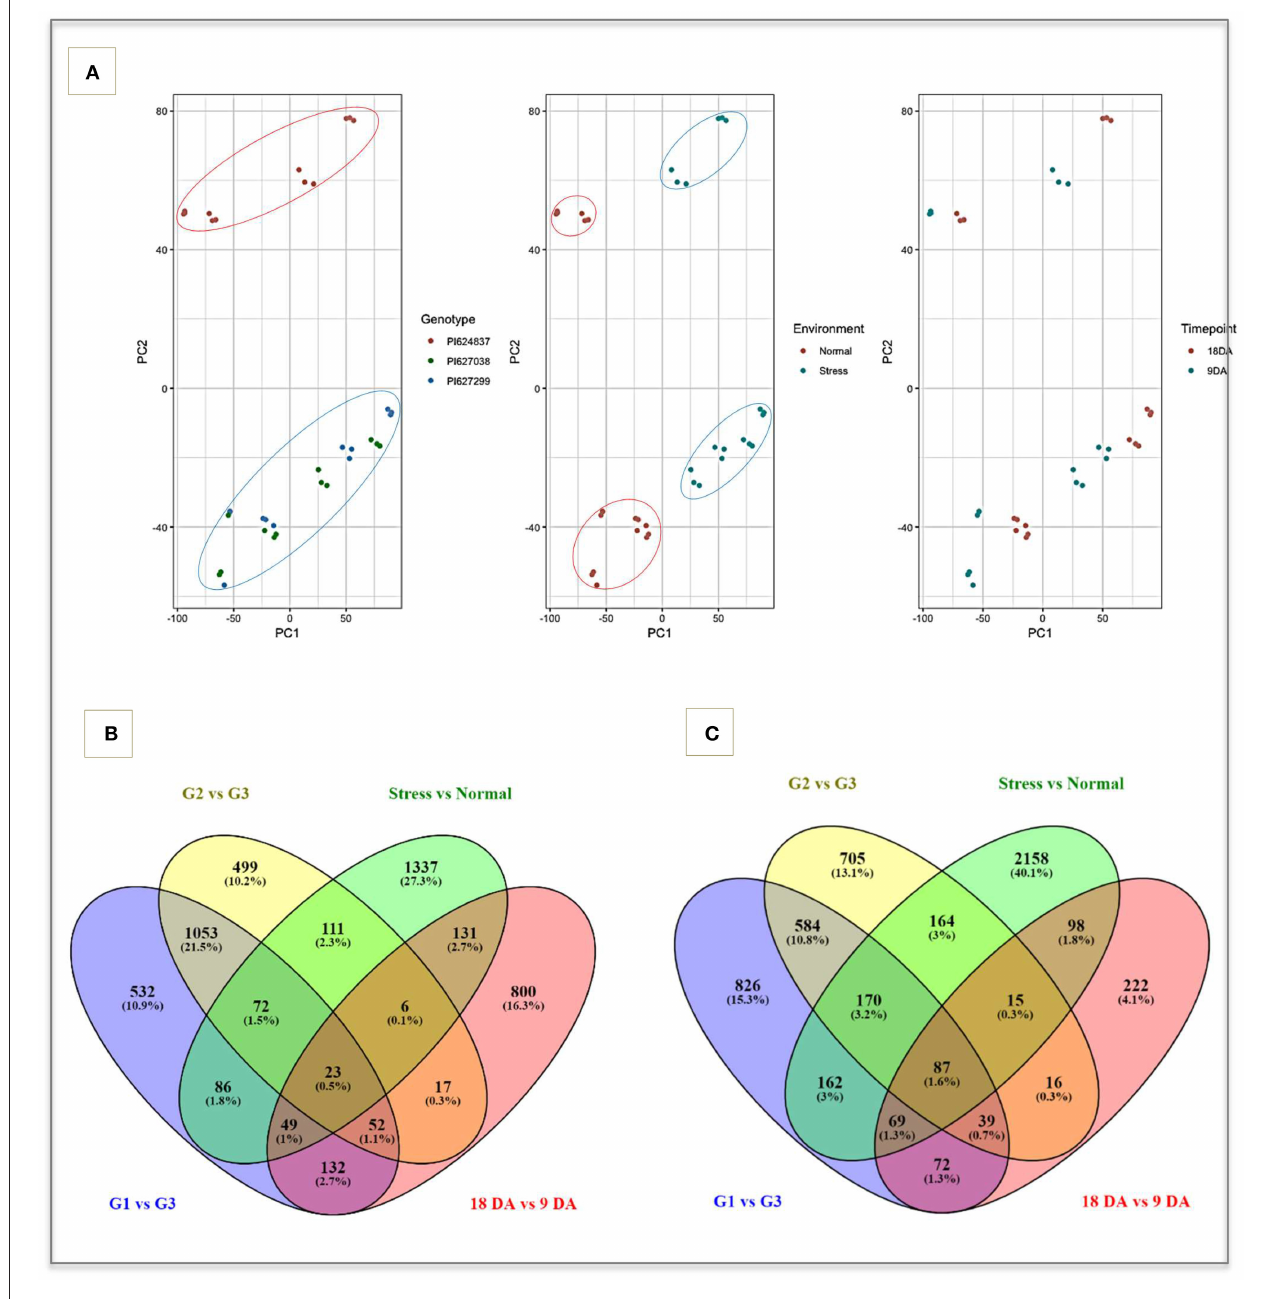
FIGURE 2 | The exploited result of VST normalization method and Venn diagrams. (A) PCA plot of samples based on three covariates including genotypes, environments and time-points that showing differentiation between tolerant (green and blue spots) and susceptible genotypes (red spots). Venn diagram of up (B) and down-regulated (C) genes in four main comparisons. G1, PI627299 (T); G2, PI627038 (T); G3, PI624837 (S); Normal, well-watering (control); Stress, water-deficit stress; 9DA, 9 days after applying water-deficit stress; 18DA, 18 days after applying water-deficit stress; T, drought-tolerant; S, drought-susceptible.